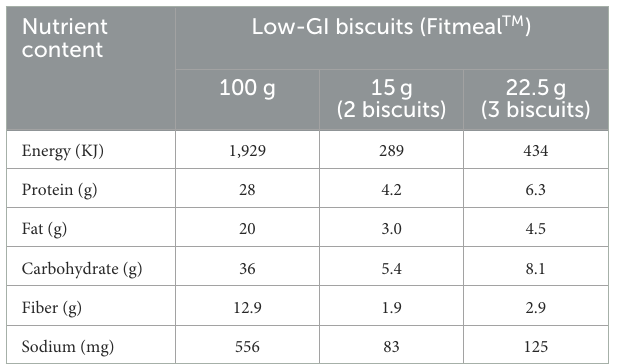
TABLE 1 Nutrient composition of low-GI